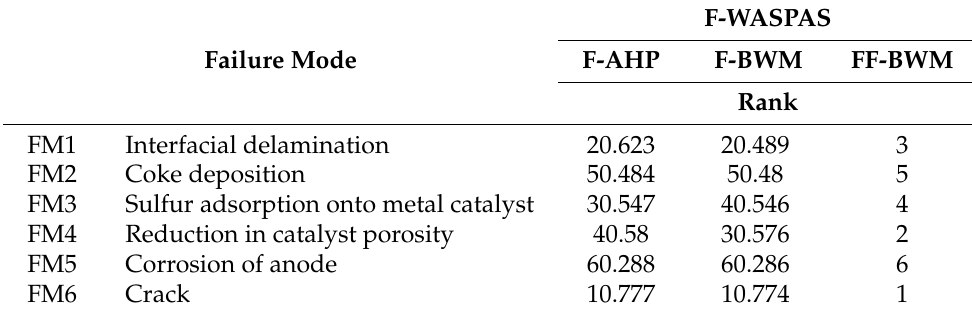
Table 13. Failure modes rank comparison for all mentioned methods.